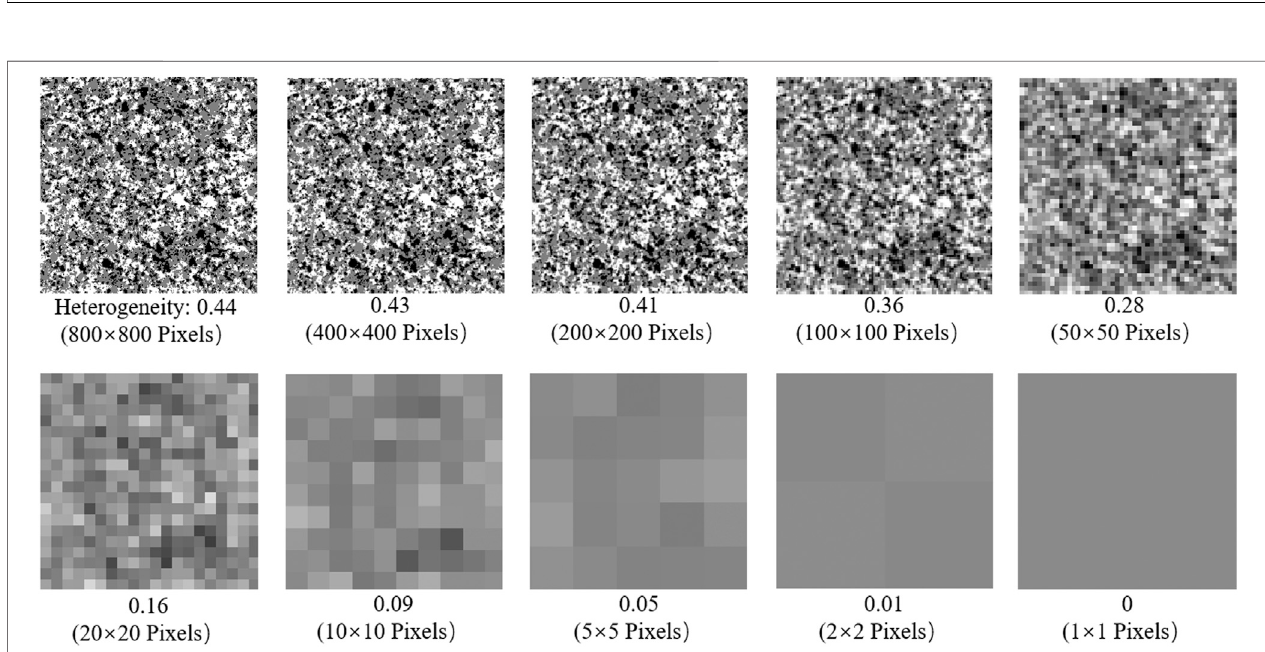
FIGURE 14 | Variation process of rock heterogeneity with different representative sizes.